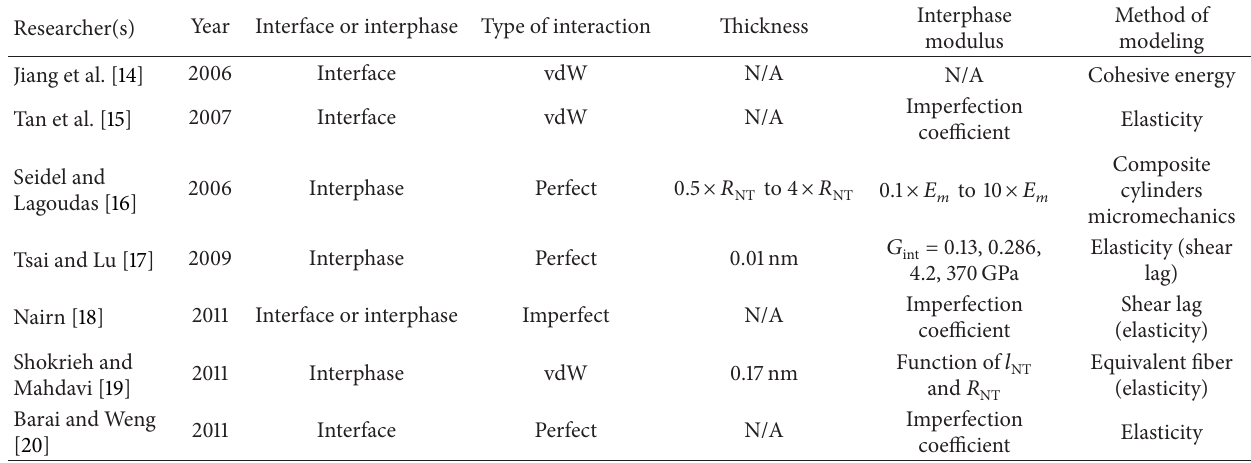
Table 2: Conducted analytical modeling of interaction between CNT and polymer.